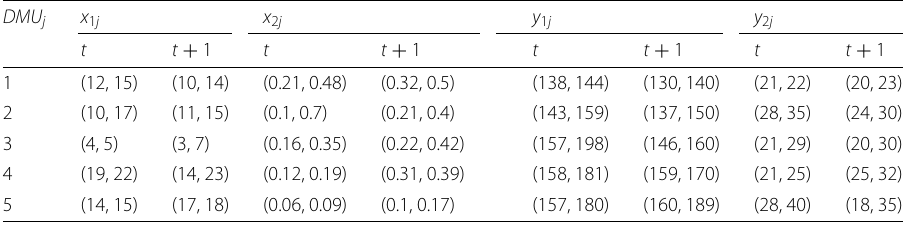
Table 1 Input and output data for the five DMUs in Example 1 at times t and t + 1. Extracted from Emrouznejad et al. (2011)